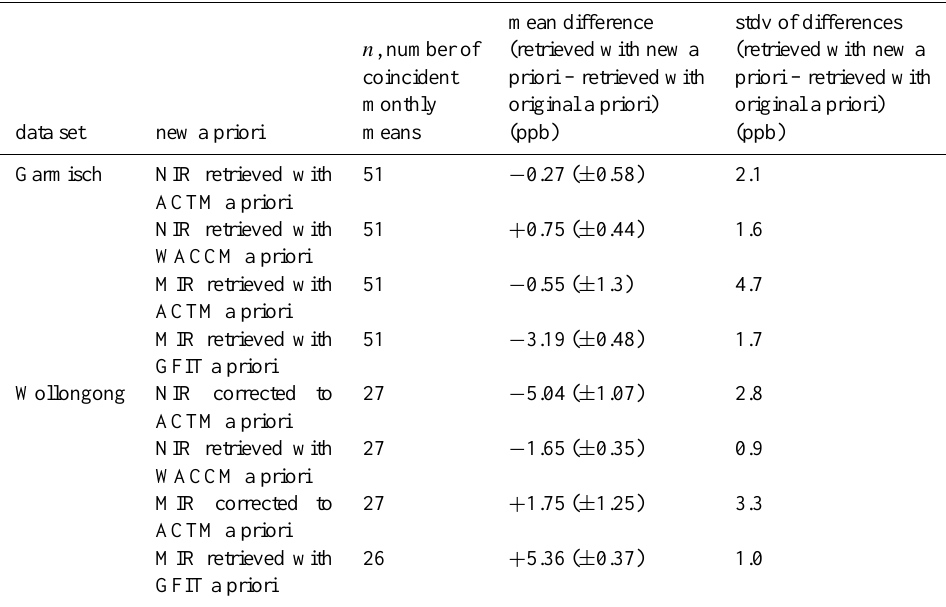
Table 2. Impact of varied a priori profiles on mean XCH 4 level retrieved in the NIR and MIR, and stdv of differences (retrieval with new a priori – retrieval with original a priori). Numbers are for monthly means constructed from same-day measurement coincidences. Uncertainties are 2 times the standard errors of the mean (2- σ /sqrt( n)) . mean difference stdv of differences n , number of (retrieved with new a (retrieved with new a coincident priori – retrieved with priori – retrieved with monthly original a priori) original a priori) data set new a priori means (ppb) (ppb) Garmisch NIR retrieved with 51 − 0.27 ( ± 0.58) ACTM a priori NIR retrieved